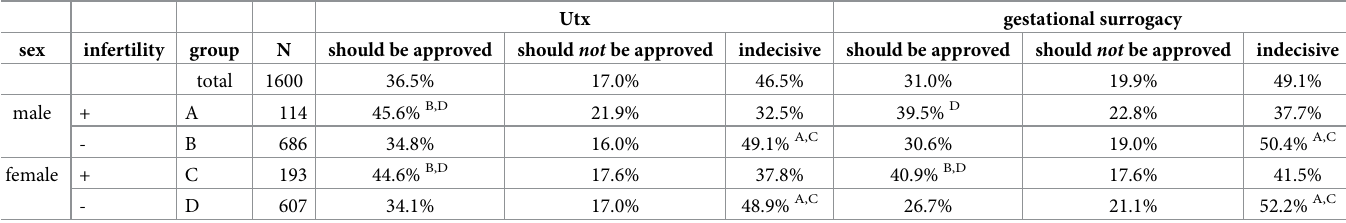
Table 3. The comparison of public attitude towards UTx and gestational surrogacy between respondents with or without infertility.